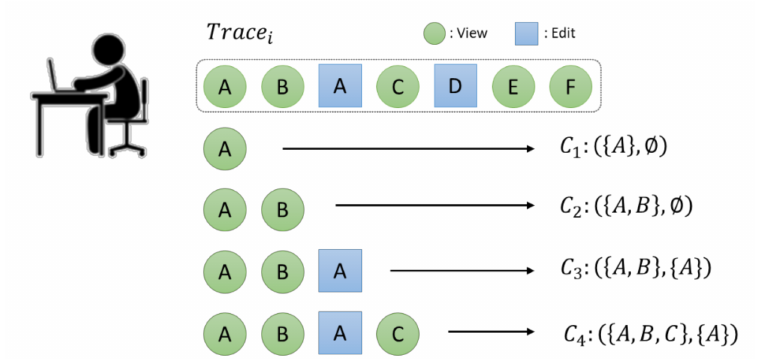
Figure 5. An example of the MI-EA process for creating a context of 3 views and 1